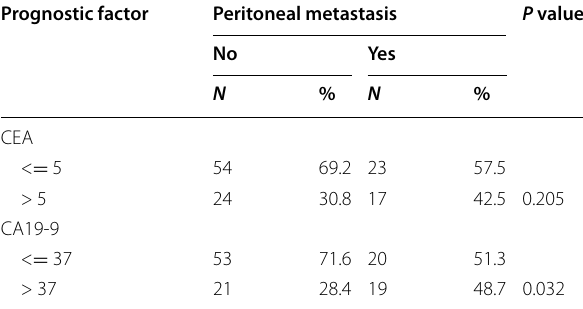
counts of < 1.9/ml ( P 0.030); and (vi) high levels of CA = 19-9 of > 37 units/ml ( P 0.032). = Table 2 shows the results of univariate logistic regression analysis of all statistically significant variables conducted using the chi-square test. Multivariate logistic regression